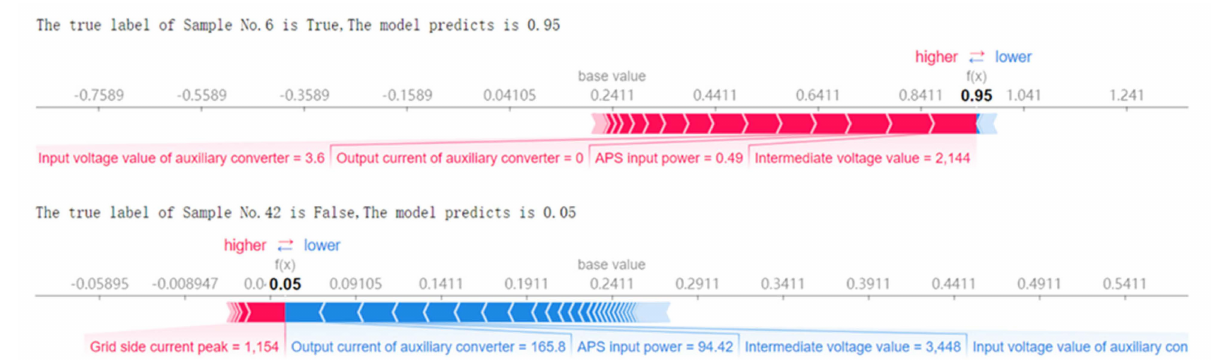
Figure 11. Visual illustration of the influence of each feature contribution’s SHAP value on the single- sample